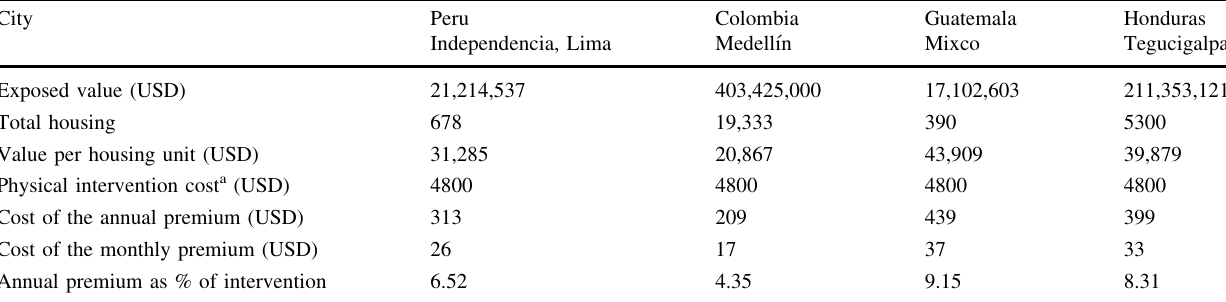
Table 8 Option 2, credit for structural retrofitting with comprehensive housing